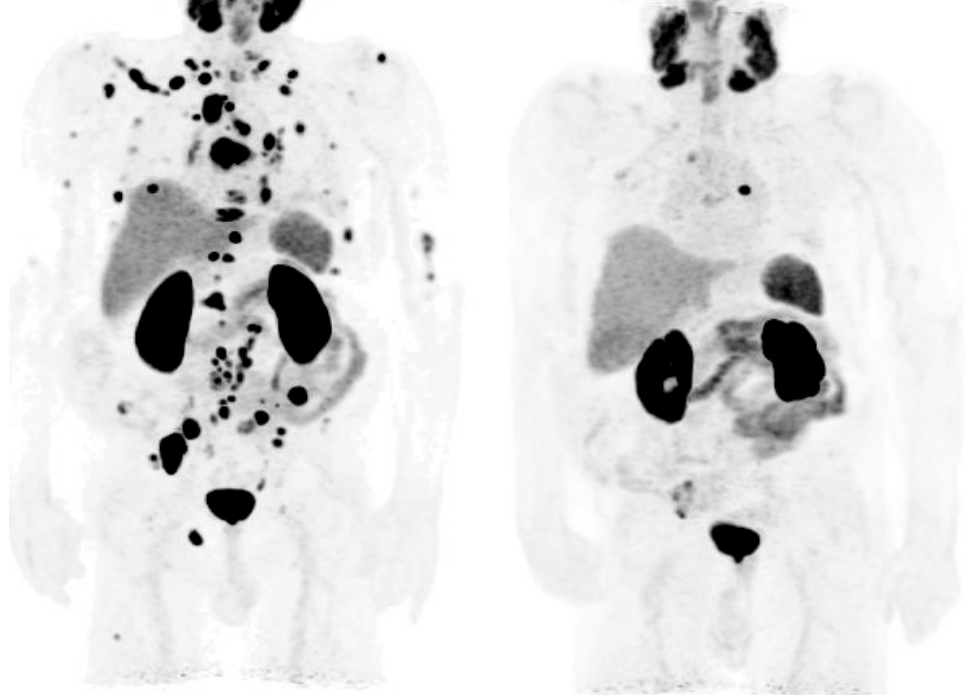
Figure 2. PSMA PET examination for evaluation of PSMA radioligand therapy. PSMA PET examination of a patient with metastatic castration-resistant prostate cancer and a PSA level of 65.74 ng/mL. Before PSMA-RLT ( left ), showing multiple bone and lymph node metastasis with highly increased PSMA-expression. After six cycles of PSMA-RLT and a PSA decline to only 1.15 ng/mL ( right ), showing a clear reduction in the number of PSMA-expressing bone and lymph node metastases.